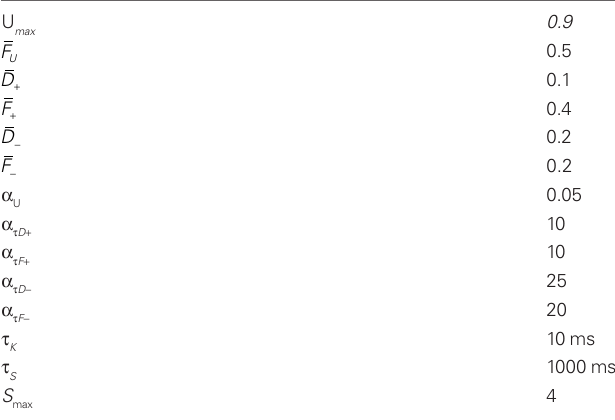
Table 1 | Values of the constants used in the computer